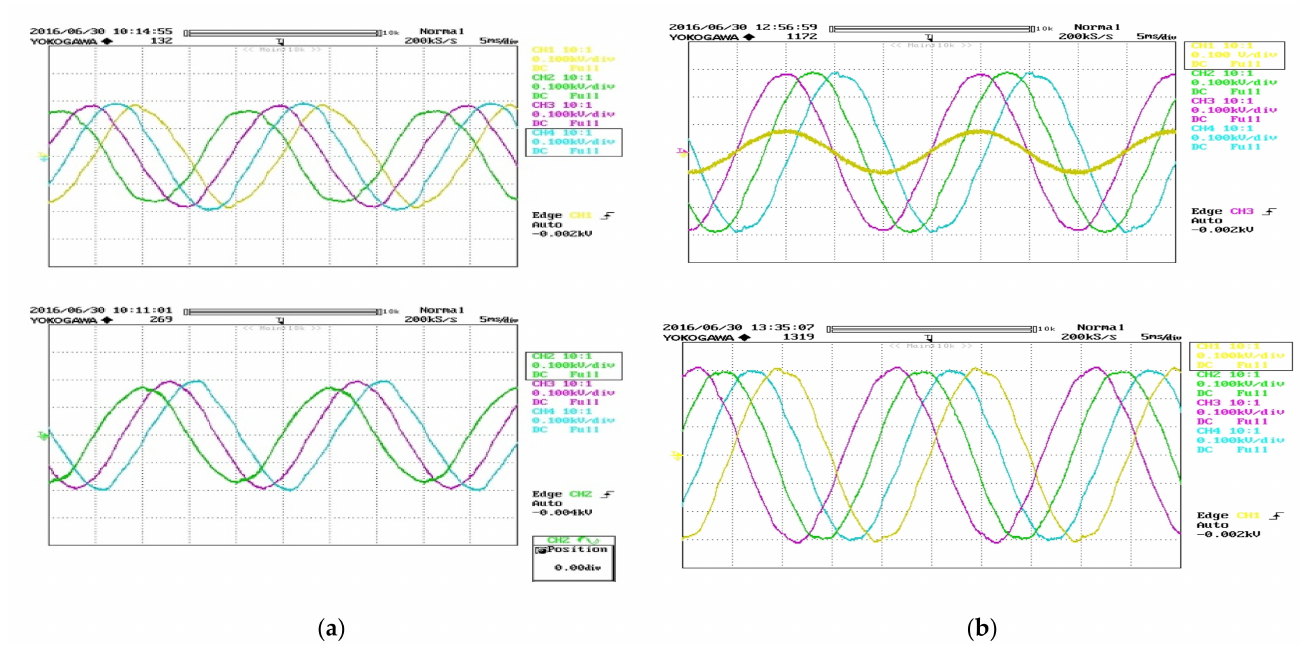
Figure 20. The experimental results for unbalanced seven-phase output voltages ( a ) Seven-phase configuration 1 ( b ) Seven-phase configuration